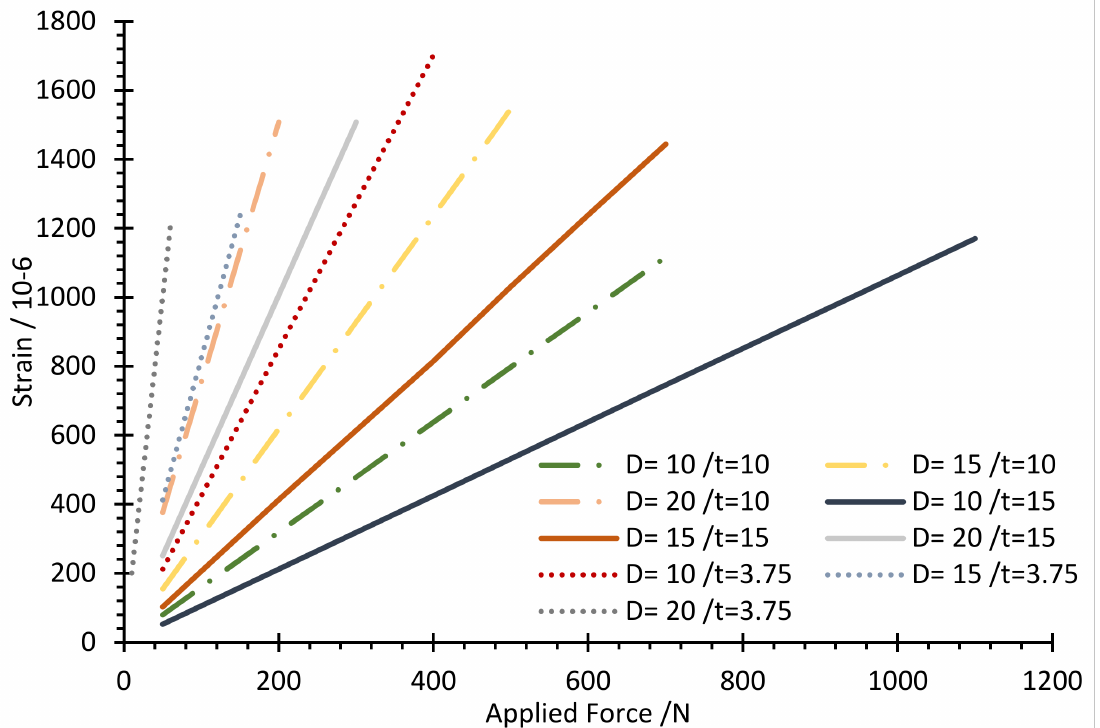
Figure 11. Maximum principal strain versus applied force for the allowable range of